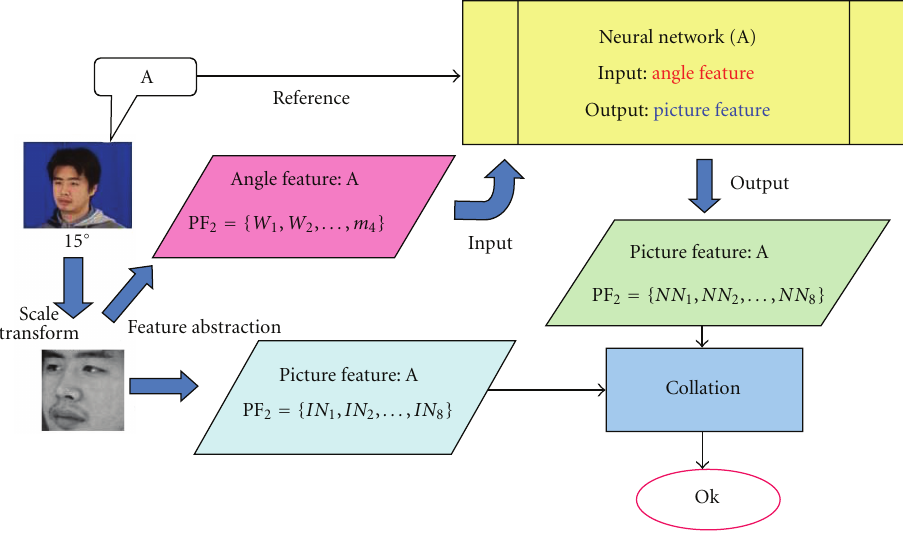
Figure 9: Description of the authentication phase. Figure 11. Though the variation of image feature is di ff erent for di ff erent images, the nature is